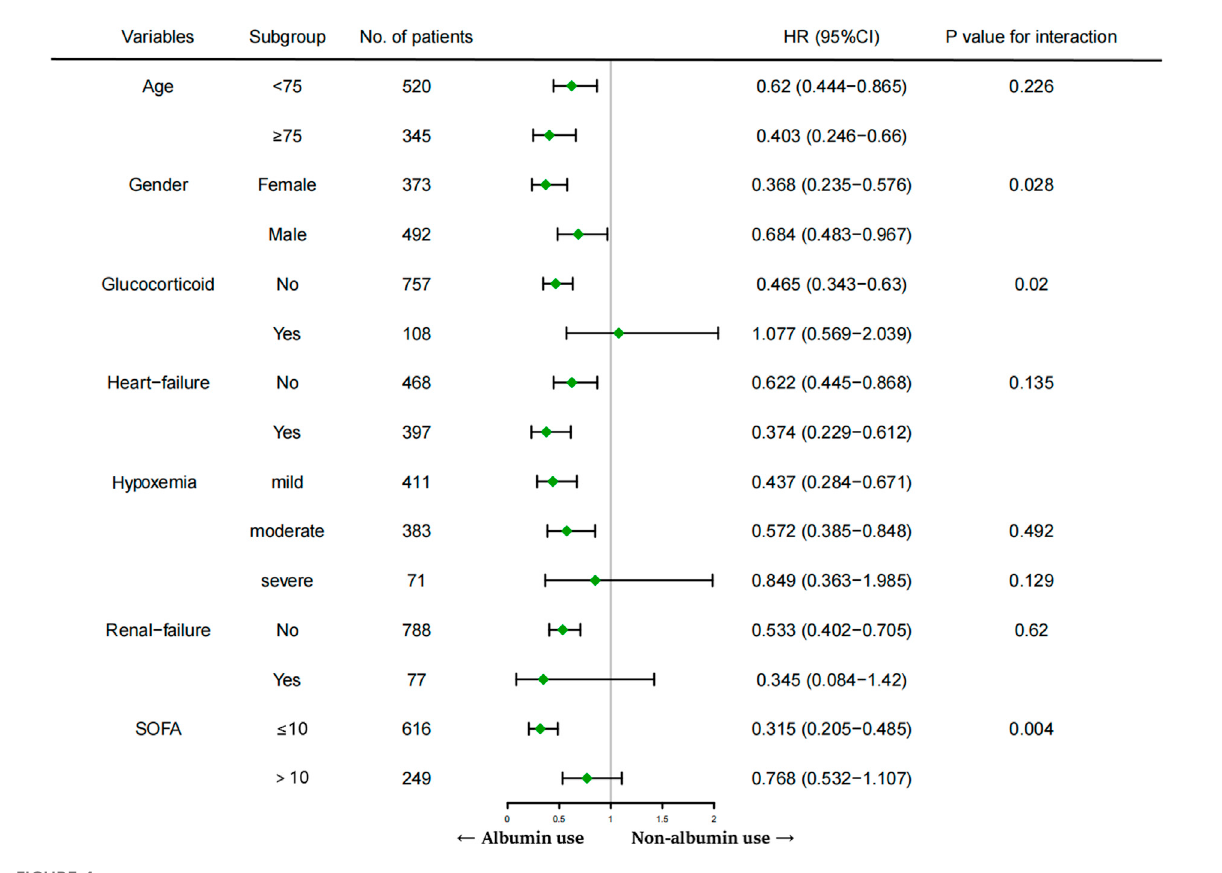
FIGURE 4 Subgroup analysis that are related to the administration of human albumin and 28-day